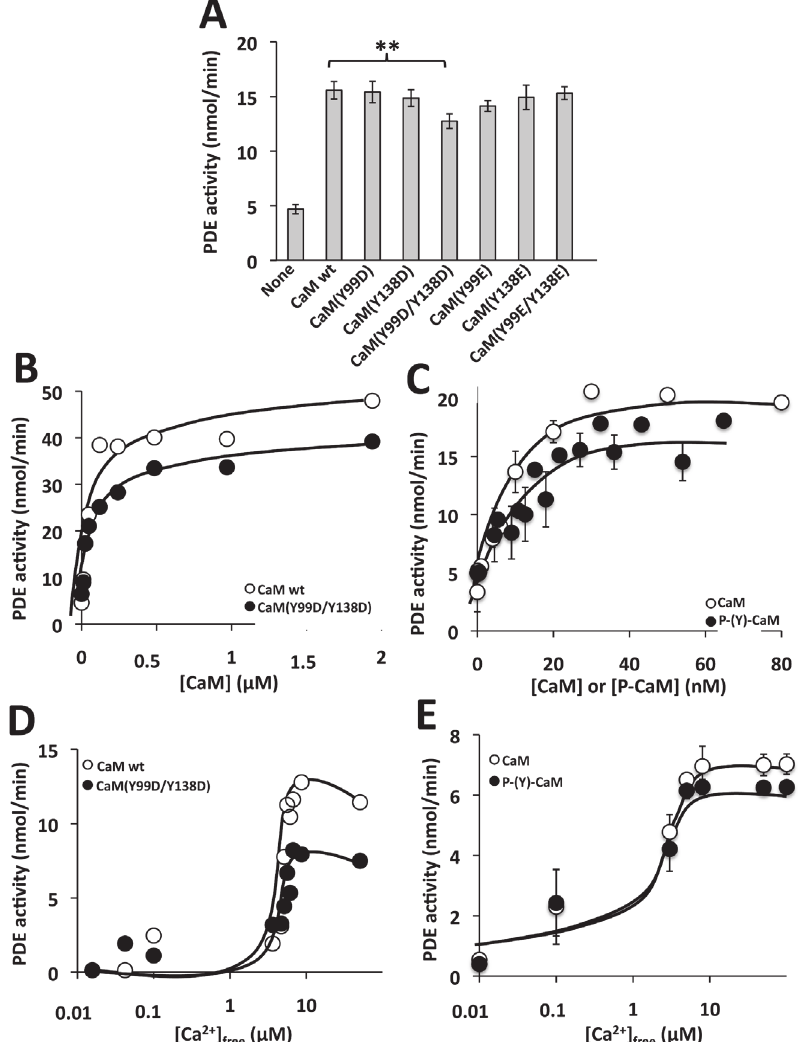
Fig 8. Effect of different CaM species on the activity of PDE1. ( A ) The cyclic nucleotide PDE1 activity was assayed in the absence ( None ) and presence of the indicated CaM species (1.9 μ M) in the presence of 100 μ M free Ca 2+ as described in Materials and Methods. The plot presents the average ± SEM of triplicate samples from three separate experiments ( ** p = 0.02 using the Student ’ s t test). ( B ) The plots present the PDE1 activity assayed as in A but using increasing concentrations of the indicated CaM species. ( C ) The plot presents the average ± SEM activity of PDE1 of three independent experiments assayed at increasing concentrations of non-phosphorylated CaM ( open symbols ) or phospho-(Y)-CaM ( filled symbols ) prepared as described in Materials and Methods. ( D ) The plot presents the PDE1 activity assayed as in A in the presence of the indicated CaM species (1.9 μ M) at increasing concentrations of free Ca 2+ using an EGTA/ Ca 2+ buffer as described in Materials and Methods. ( E ) The plot presents the average ± range activity of PDE1 assayed in the presence of non-phosphorylated CaM ( open symbols ) and phospho-(Y)-CaM ( filled symbols ) (0.97 μ M) of two independent experiments assayed at increasing concentrations of free Ca 2+ using an EGTA/Ca 2+ buffer as described in Materials and Methods. ( (cid:3) 0.1 μ M) were observed between wild type and the double Y/E CaM mutant. In contrast, a ( (cid:3) 30%) with respect to wild type CaM was noticeable with CaM slight increment in the V max (Y99E/Y138E). Similarly, phospho-(Y)-CaM increased the activity of eNOS more efficiently ( (cid:3) 30%) than non-phosphorylated CaM (Fig 10C). When the assays were performed at